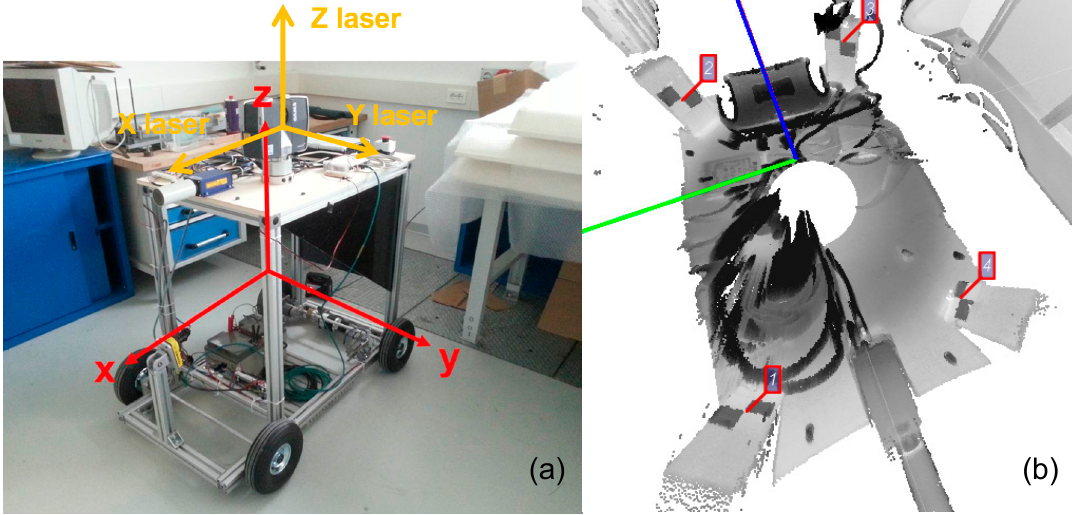
Figure 5. Laser Scanner reference systems on the cart ( a ) and 3D scan of the set of four markers located on the cart (as seen from the laser scanner, ( b )).